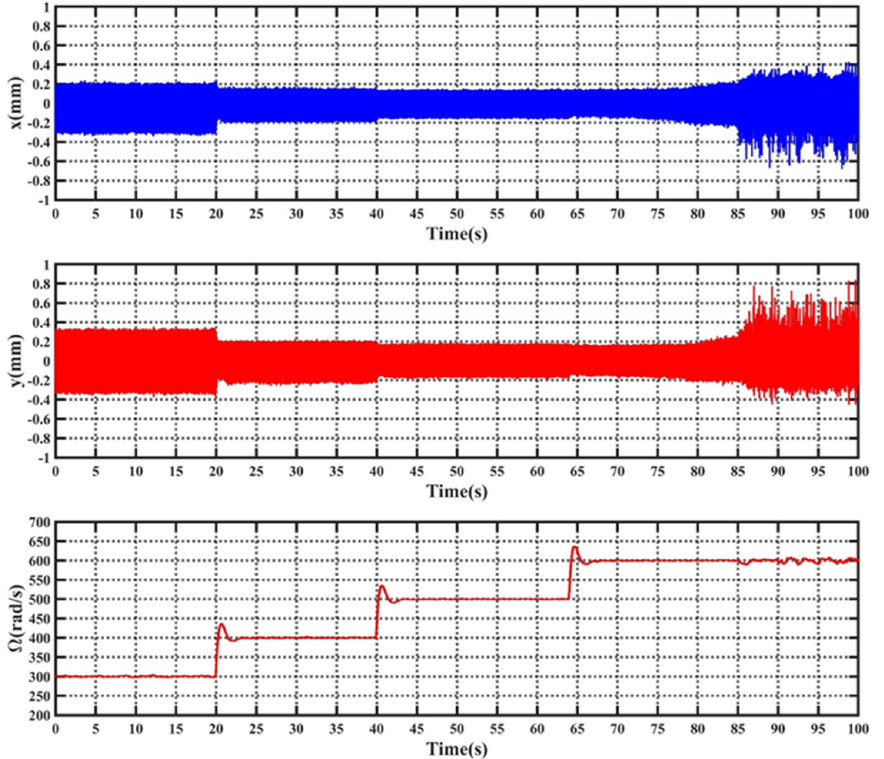
Figure 13. Experimental results: when Z s = − 2.2 mm, the radial vibration displacements in x - and y - directions are presented corresponding to different rotary speeds.